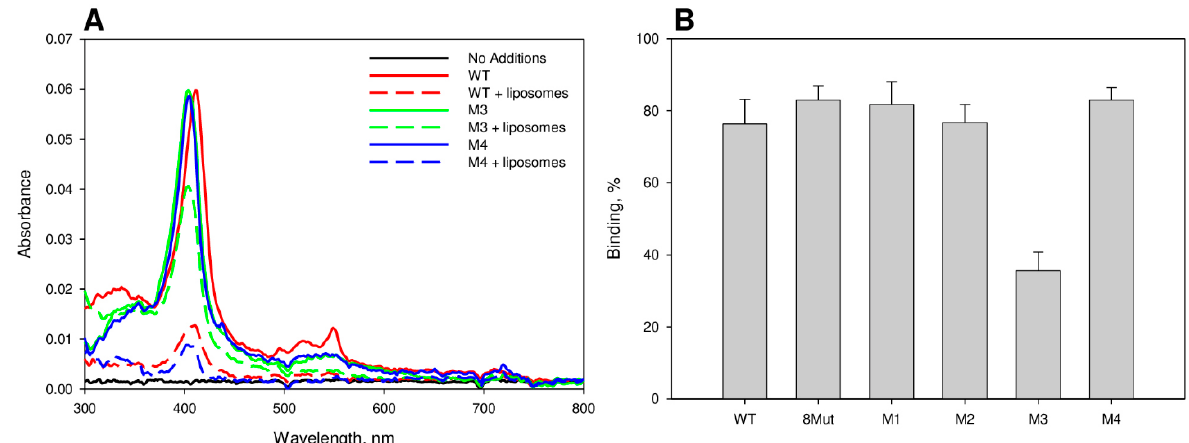
Figure 1. Absorbance spectra ( A ) of supernatants obtained after centrifugation of WT CytC and its mutants with various substitutions in the absence (solid lines) and in the presence (dashed lines) of CL-containing liposomes, and a histogram ( B ) showing the extent of the binding of mutant forms K8E/K27E/K72E/K86E/K87E/E62K/E69K/E90K (8Mut), T78N/K79Y/M80I/I81M/F82N (M1), T78S/K79P (M2), I81Y/A83Y/G84N (M3), and P76I/G77L/I81L/F82L (M4) to the liposomes. Results are expressed as mean ± SE of at least three experiments.